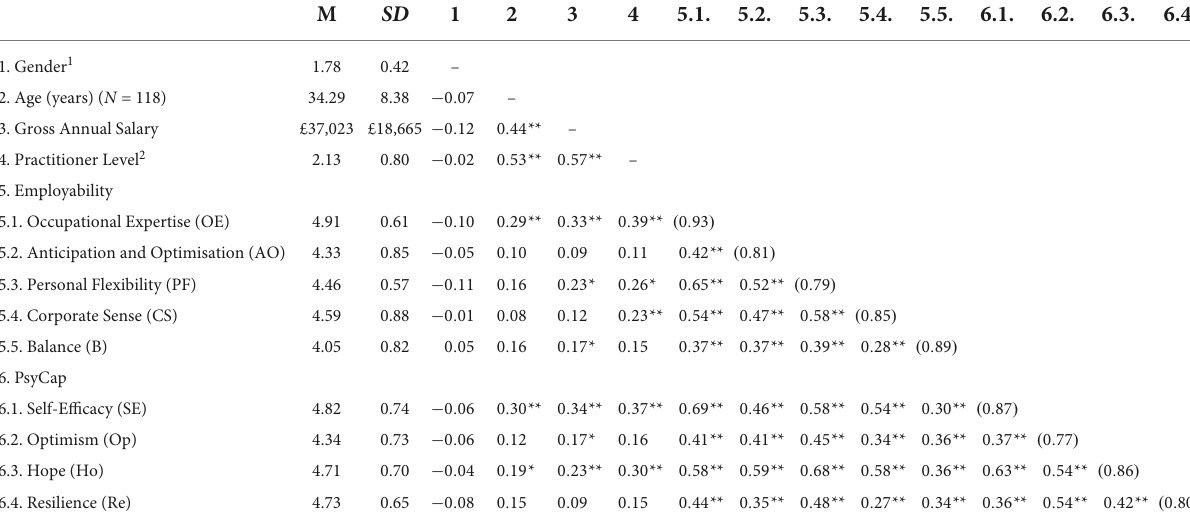
TABLE 1 Descriptive statistics and correlation coefficients of the study variables (diagonal/parentheses represent Cronbach’s alpha). M